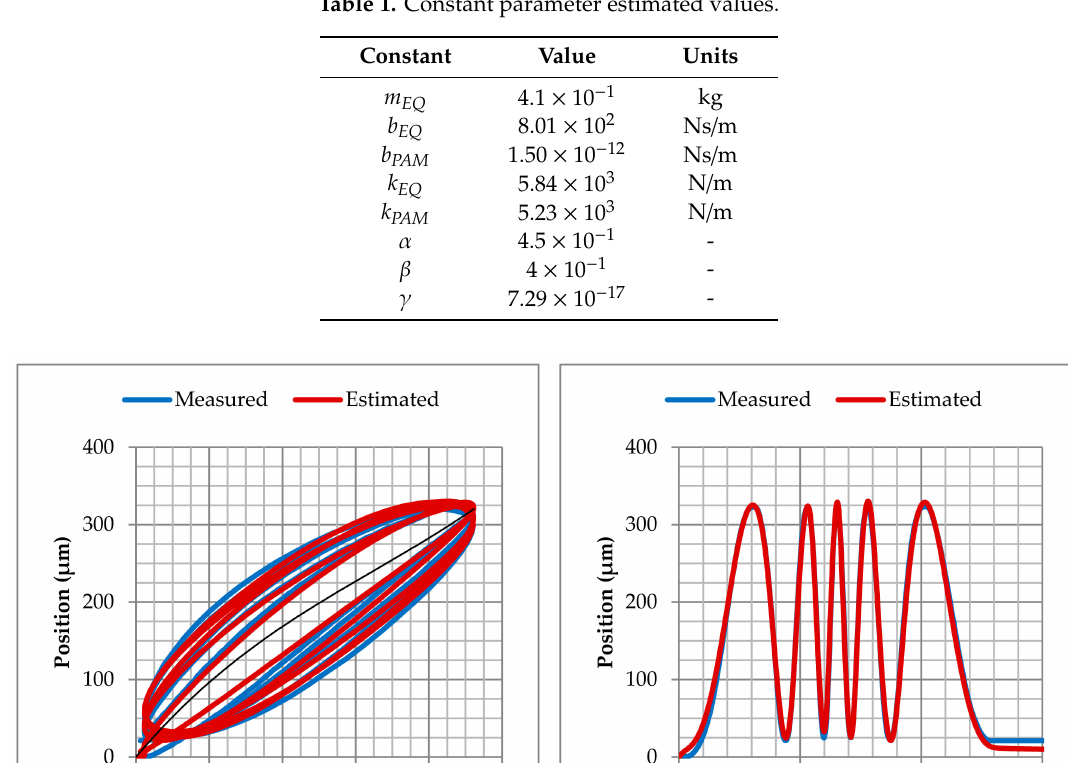
Table 1. Constant parameter estimated values.